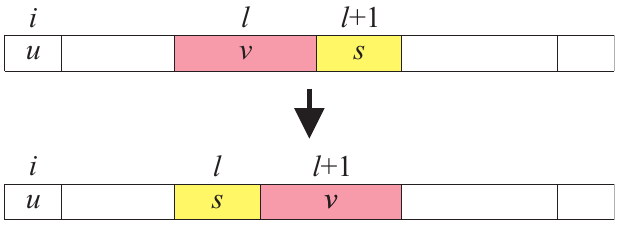
Figure 3. Interchanging facility s with its left neighbor v